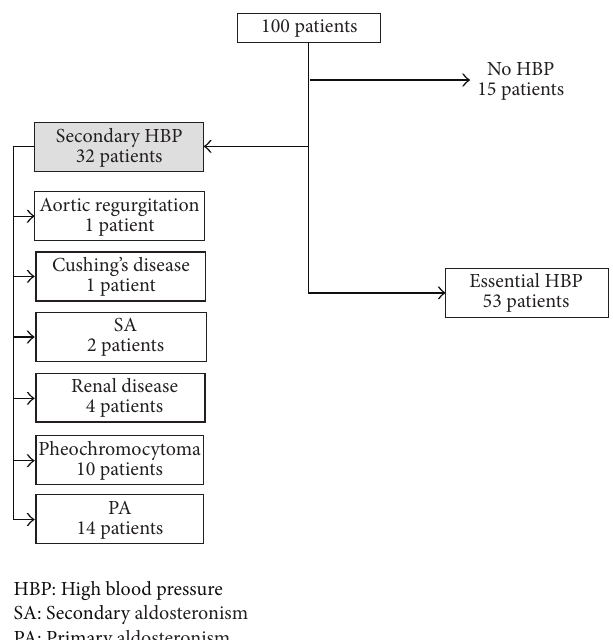
Figure 1: Diagnostic workup of the patients. HBP, high blood pressure; PA, primary aldosteronism; SA, secondary aldosteronism.